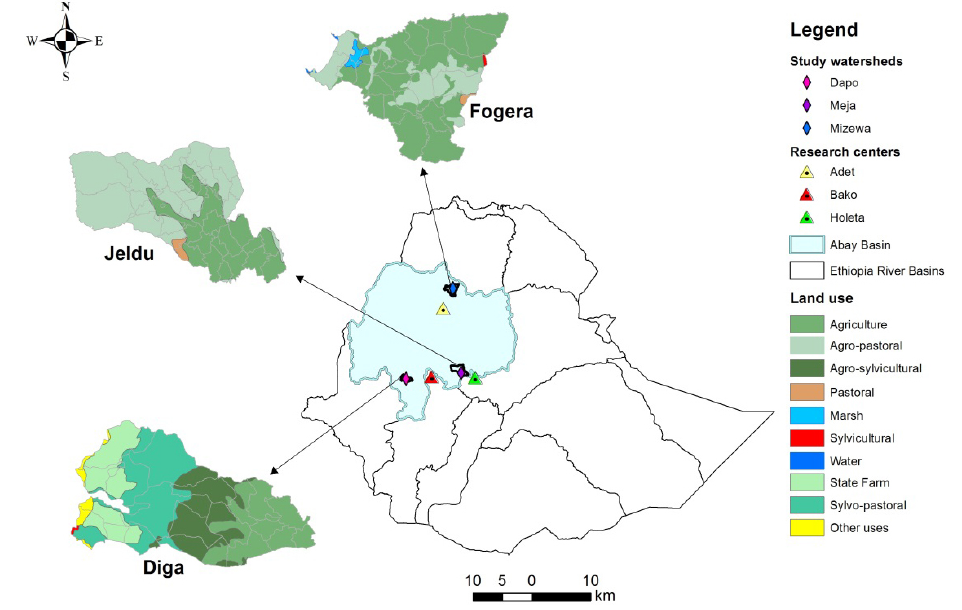
Figure 1. Location and land use map of the study sites with the nearest agricultural research centres. Table 1. Description of the three study watersheds based on office of agriculture annual report (2006 to 2010), ILRI Baseline Survey (2010) and own